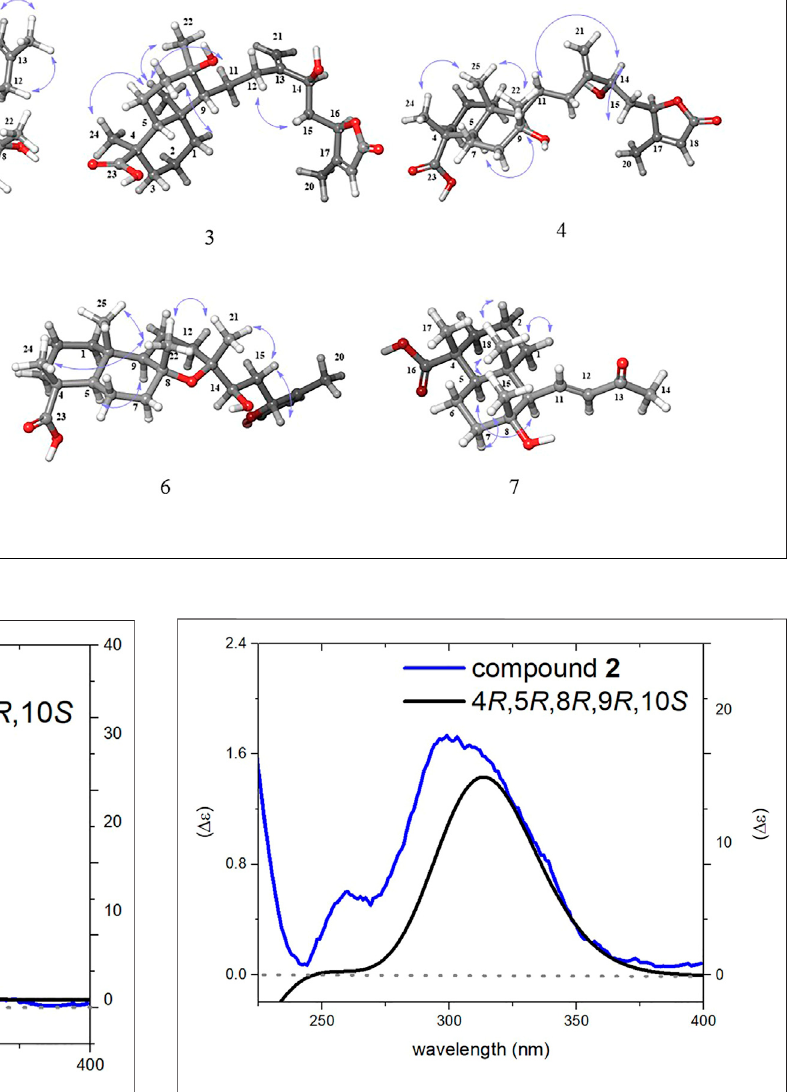
FIGURE 5 | Comparison of experimental and calculated ECD spectra of compound 2 at TD-DFT/cam-B3LYP/6-31G(d,p) theory in